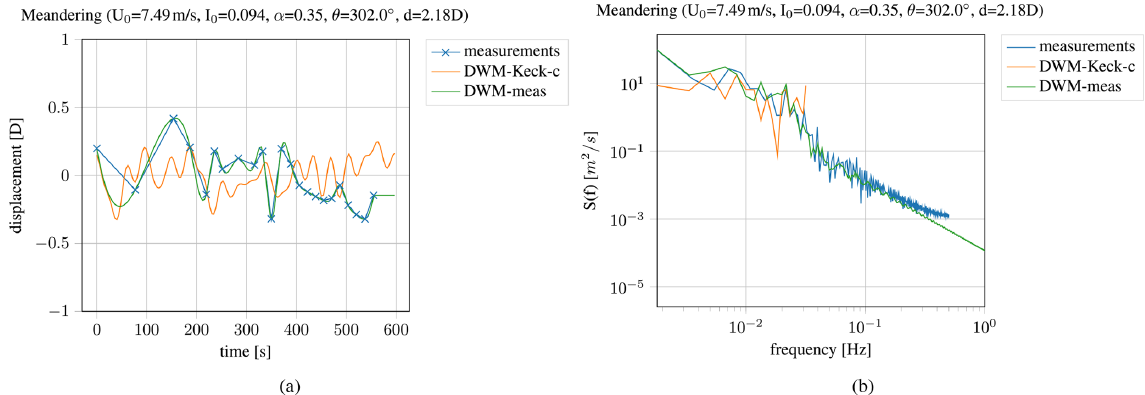
Figure 5. Time series (a) and power spectrum (b) of the meandering, measured and simulated with the calibrated DWM-Keck-c model as well as the interpolated time series (DWM-meas).